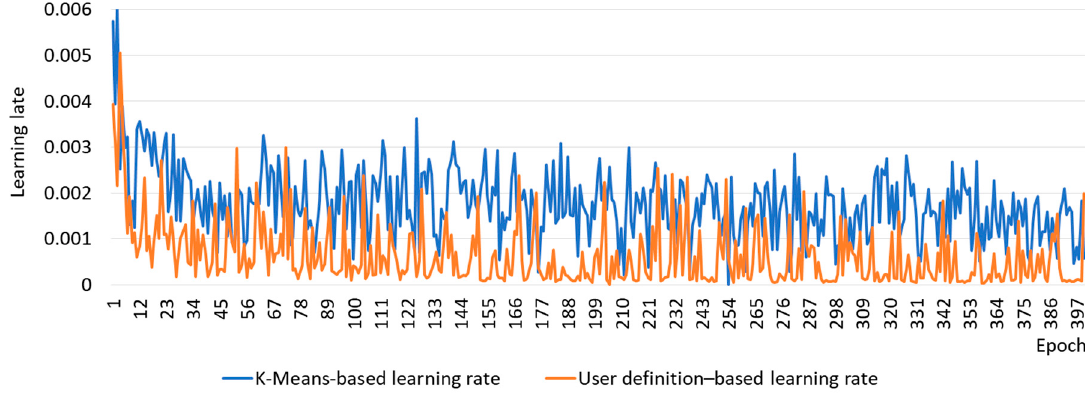
Figure 10. Change in the learning rate when the 360-degree video control signal is learned by the CNN model.